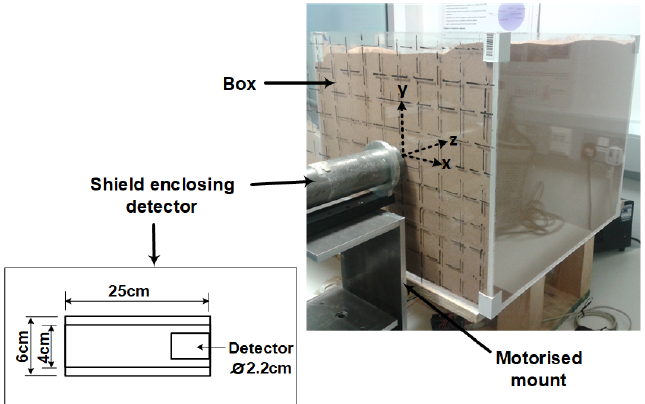
Figure 3. Setup for the gamma ray measurements. The Cs-137 point source was placed at varying position along the z -axis using a pipe that protruded behind the box, while the intensity was measured at the desired positions on the surface of the